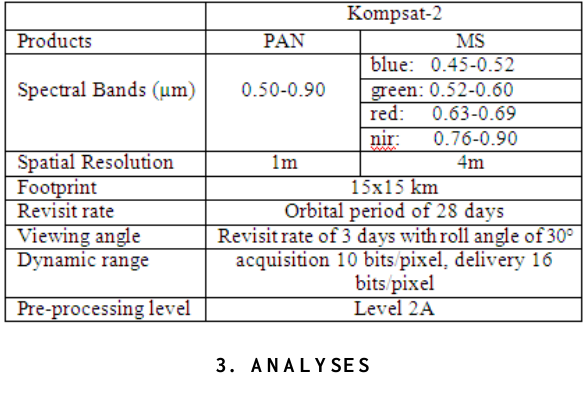
Table 2 Technical characteristics of Kompsat-2